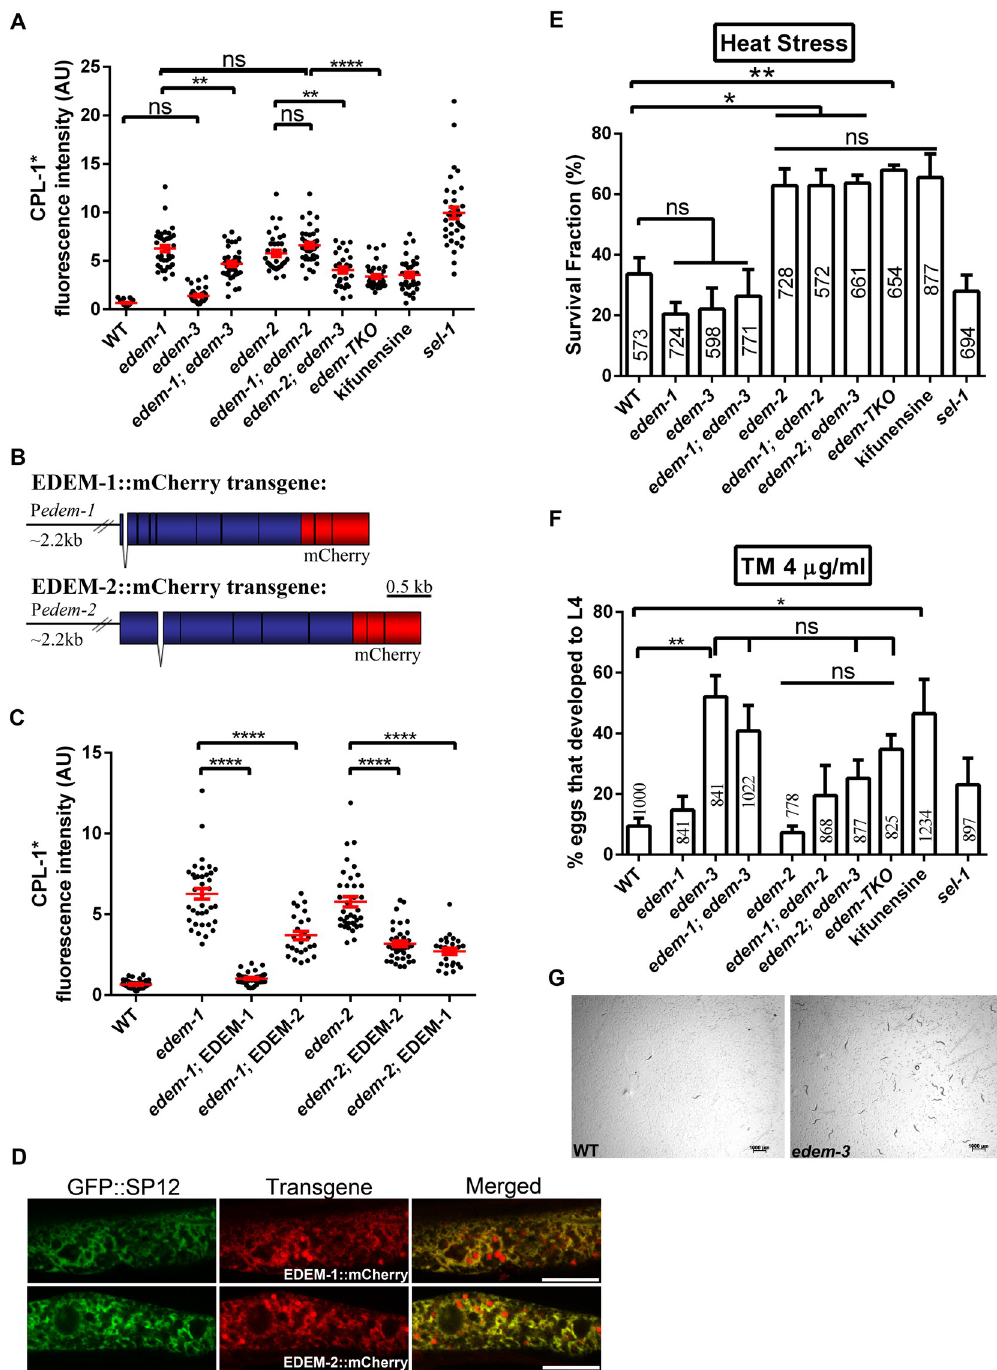
Fig 5. edem mutants respond differently to ER stress. (A) Fluorescence intensities of indicated strains carrying the CPL-1 � transgene. Dots in scatter gram represent mean fluorescence/ μ m 2 x 1000 in arbitrary units (AU). (B) Schematic structure of P edem-1 ::EDEM-1::mCherry and P edem-2 ::EDEM-2::mCherry transgenes. Exons are indicated by blue boxes separated by black lines indicating introns. The transgenes include the sequence of the first intron. (C) Quantification of CPL-1 � fluorescence in edem-1 and edem-2 mutants harbouring or not EDEM-1 or EDEM-2 transgene. Dots in scatter gram represent mean fluorescence/ μ m 2 x 1000). (D) EDEM-1::mCherry and EDEM-2::mCherry expressed from the transgenes localize correctly to ER. Confocal images of the ER marker GFP::SP12 and EDEM::mCherry in WT animals demonstrating ER colocalization in merged. Exposure adjustments were uniformly applied. (E) Survival fraction of the indicated